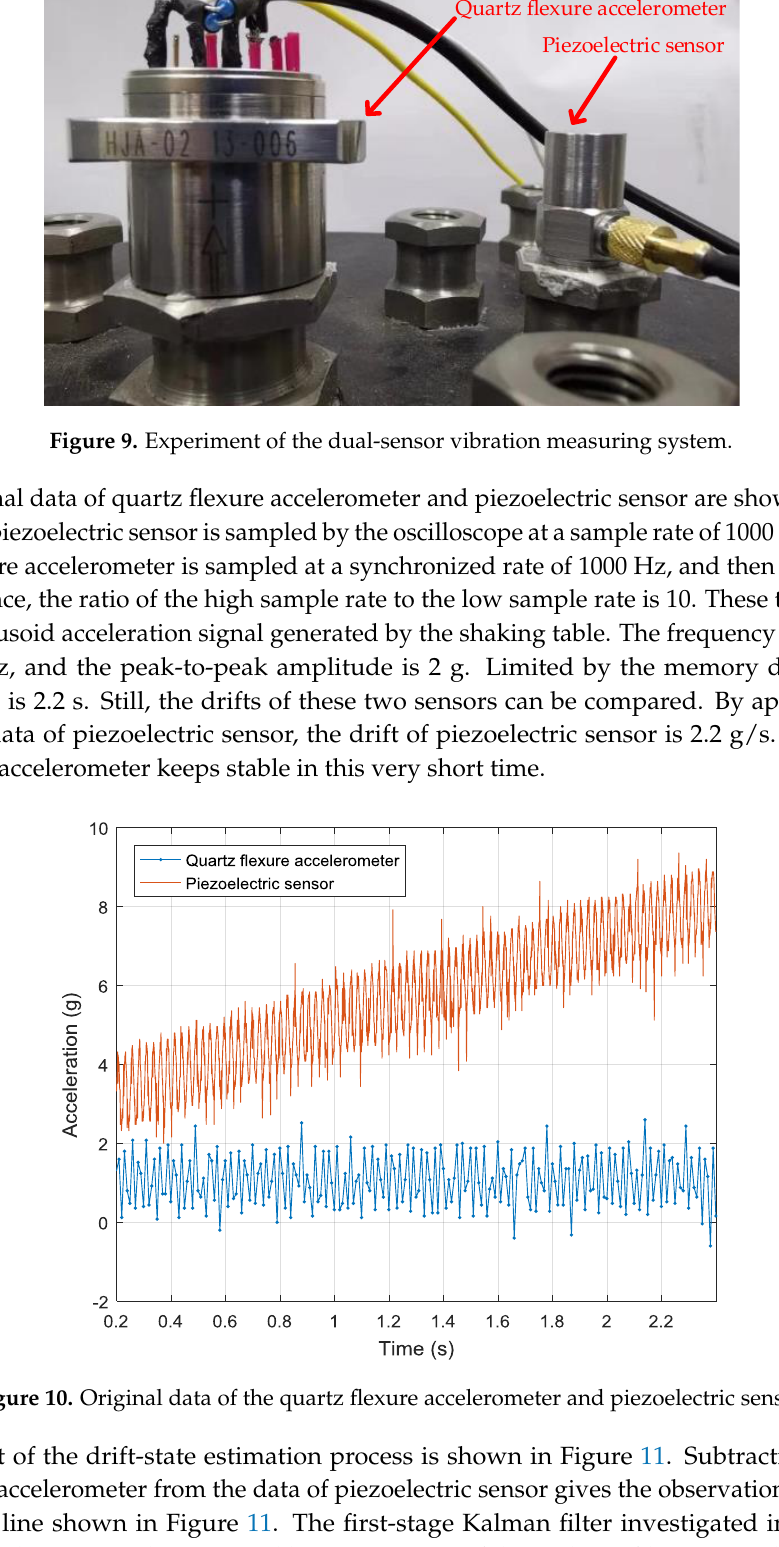
Figure 10. Original data of the quartz flexure accelerometer and piezoelectric sensor.